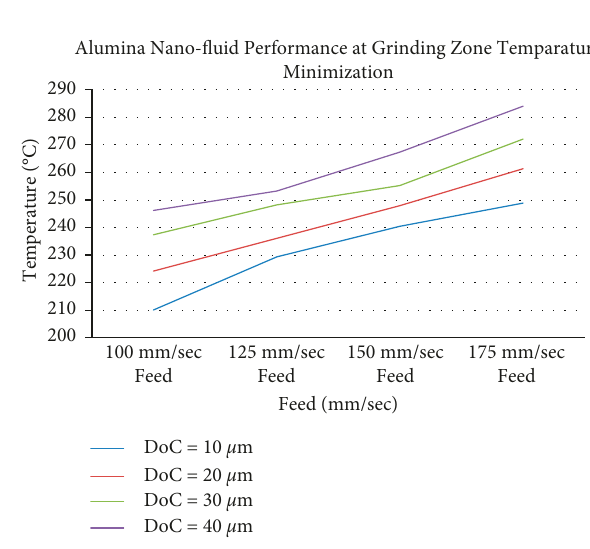
Figure 3: Alumina nanofluid performance in downsizing grinding zone temparature.